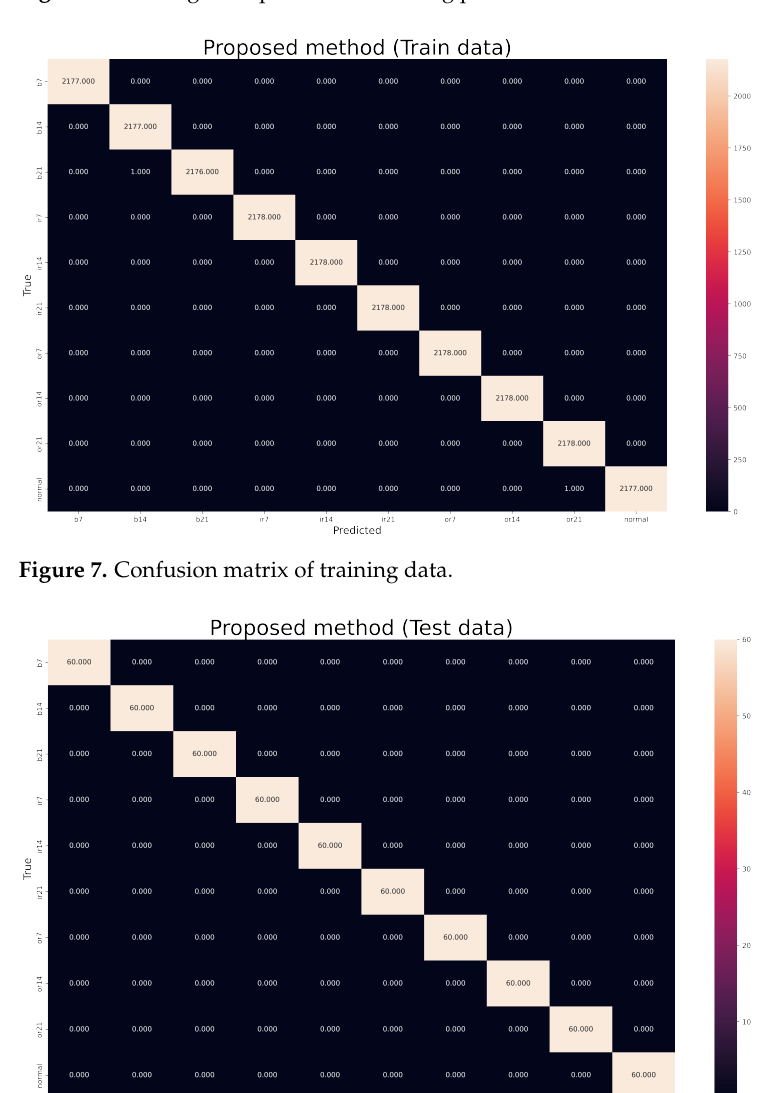
Figure 6. Convergence speed in the training phase.